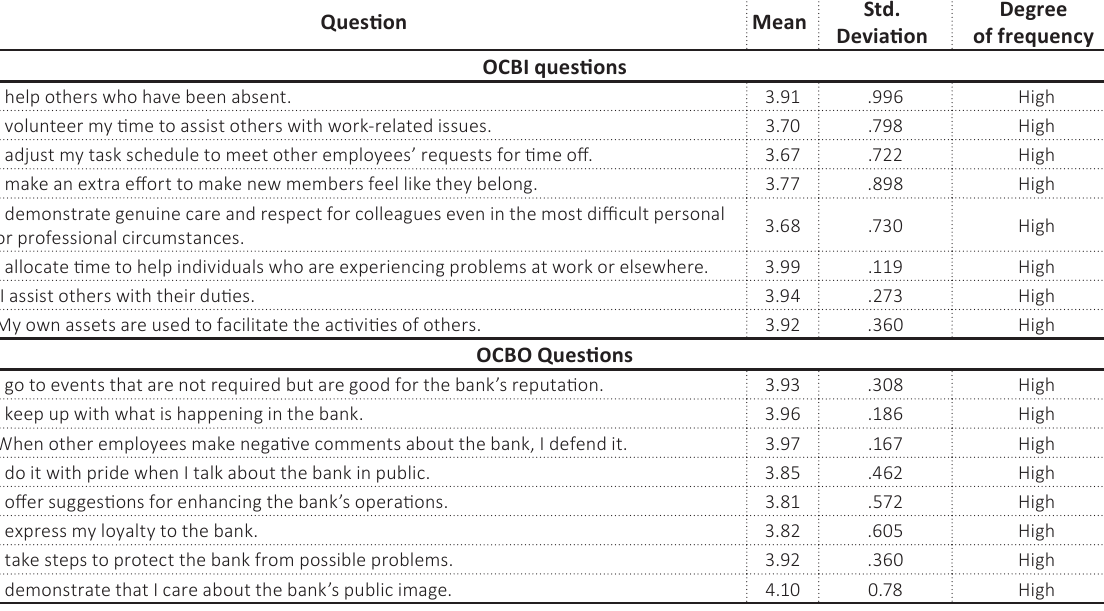
Table 3. Descriptive statistics for organizational citizenship behavior